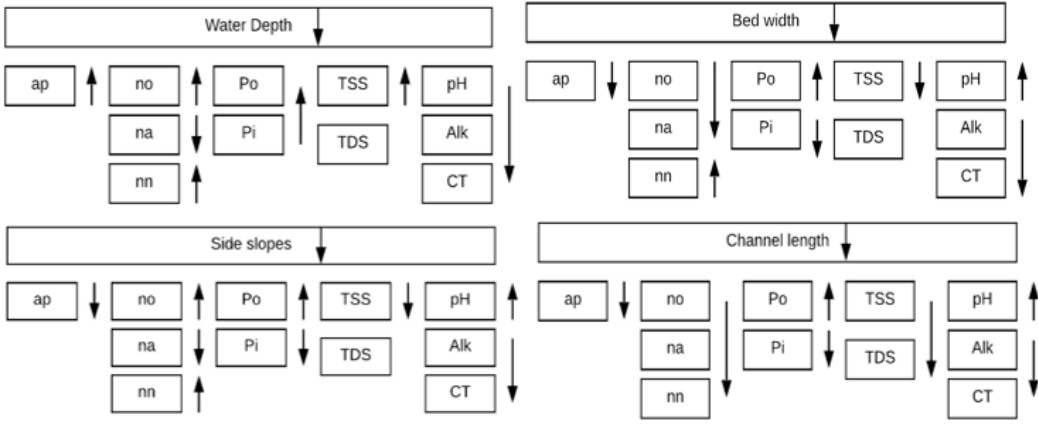
Figure 3. Graphical plot for different geometric parameters and their effect on the studied water quality variables.